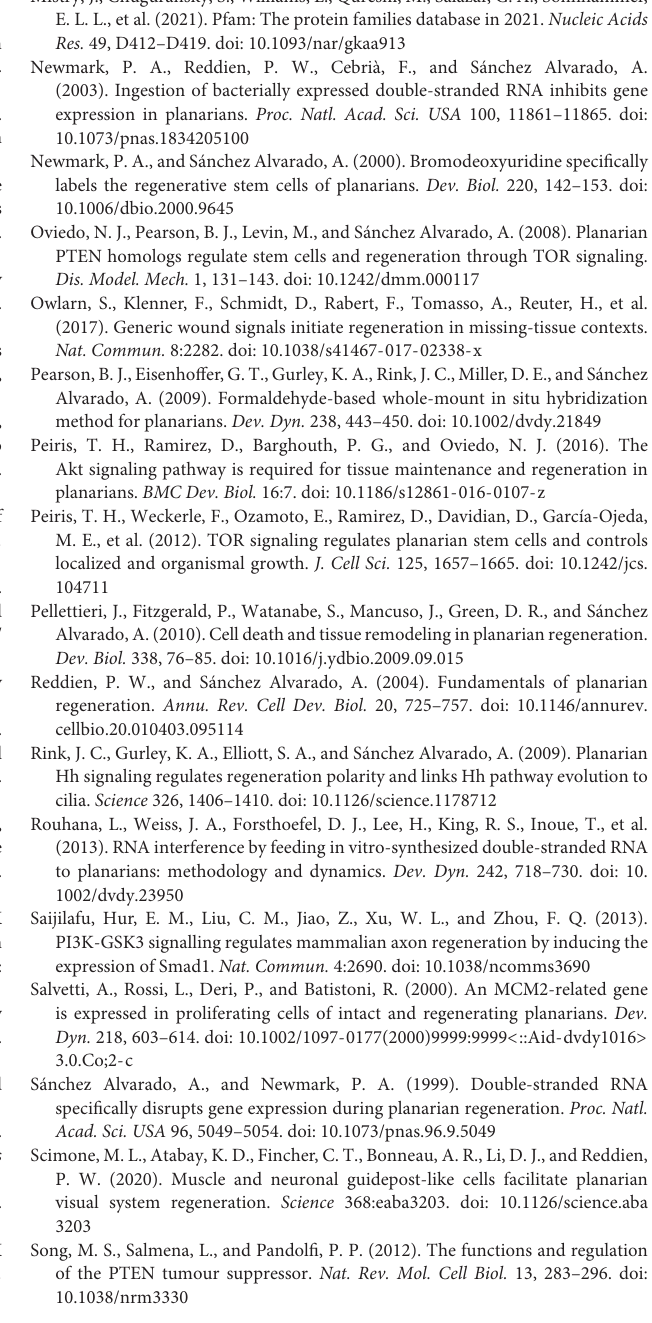
and tail fragments. The expression level of Djbax at 0 hpa was set to one. ∗∗ P < 0.01, ∗∗∗ P < 0.001, and ns, not significant, by the Student’s t -test. Supplementary Video 1 | Representative video showing the gliding ability of control animals. All control animals moved quickly away from the light and reached the dark field within 2 min when exposed to light. Supplementary Video 2 | Representative video showing the gliding ability of LY294002-treated animals. Two-third of the LY294002-treated animals never arrived at the dark field even at 20 min post light exposure, exhibiting photophobic but impaired locomotion behaviors including twisting, flipping, and staying